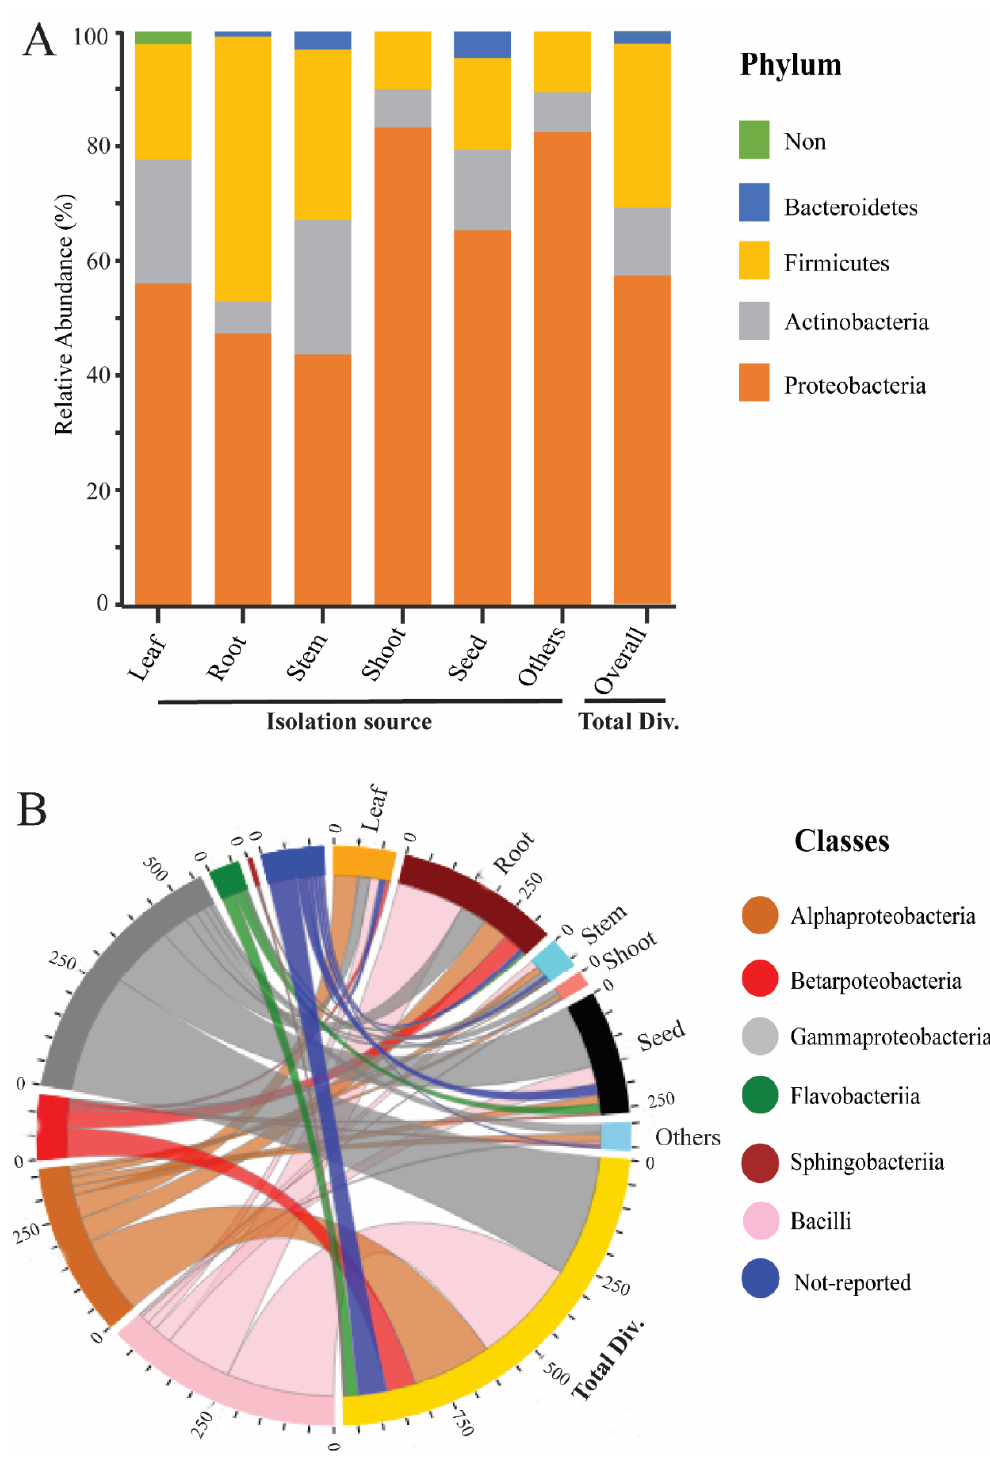
Figure 2. Relative abundance of rice endophytic bacteria diversity within rice tissues. ( A ) Endophytic bacteria diversity at the phylum level; the isolation sources were plotted on the horizontal axis, and relative percentage of phyla is visualized by the vertical axis, each taxon showed with specified color in stacked columns. ( B ) 3D chord diagram illustrates the rice endophytic bacteria diversity at the class level; each arc shows overlapping diversity within rice tissues; 3D visualization available on following link https://beta.rstudioconnect.com/connect/#/apps/42c60c75-8ff2-4dce-ad48-c1446c8ccb55/access, accessed on 5 September 2021 Total Div.: presenting the total diversity within rice tissues (leaf, root, stem, shoot, seed, and including other sources). Other: including isolation sources of rice (grain filling, tillage stages, and also not-conformed